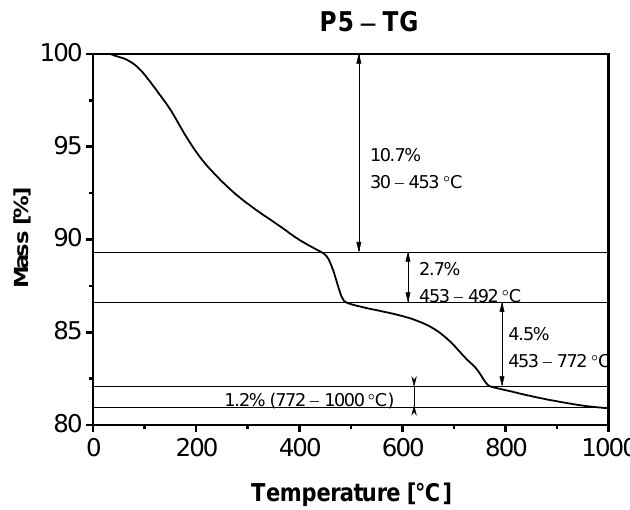
Figure 8. TGA of sample P5 after 28 days of curing.